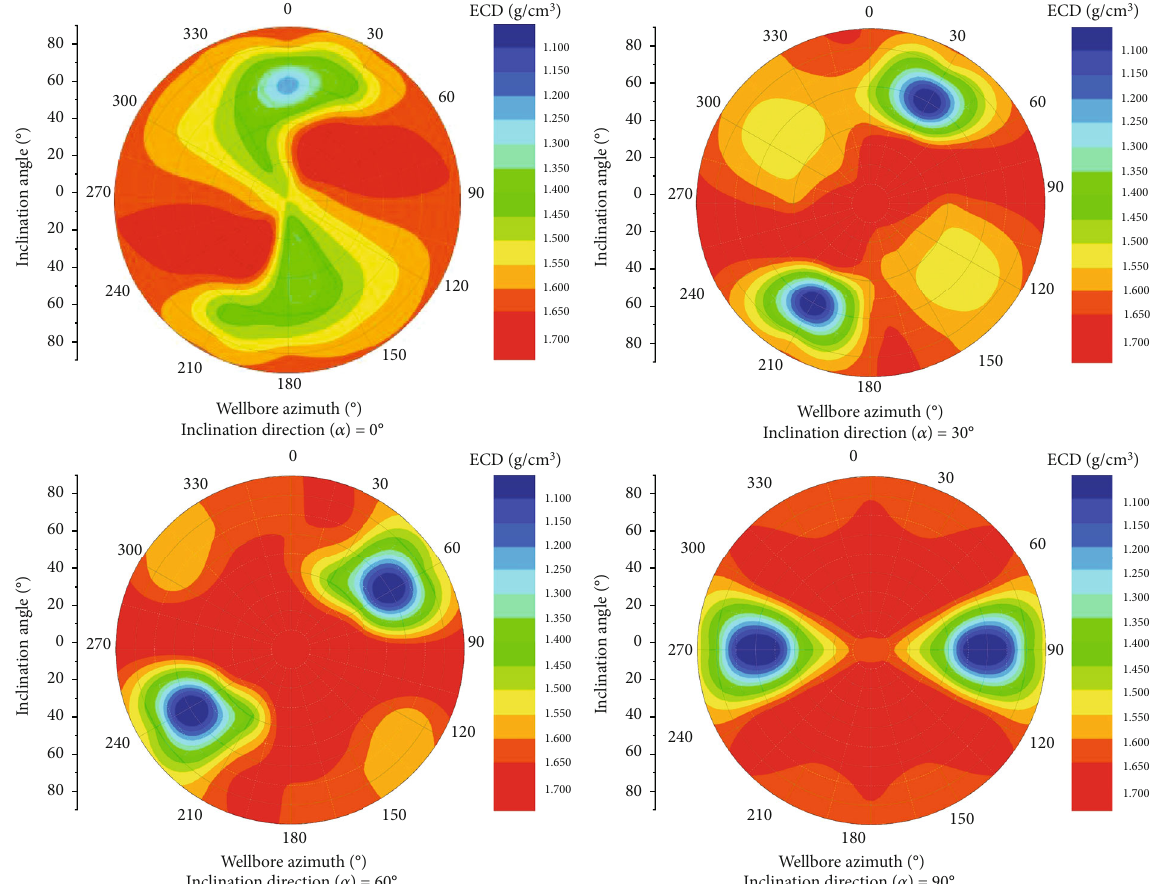
Figure 6: The inclination angle of bedding plane is 60 °